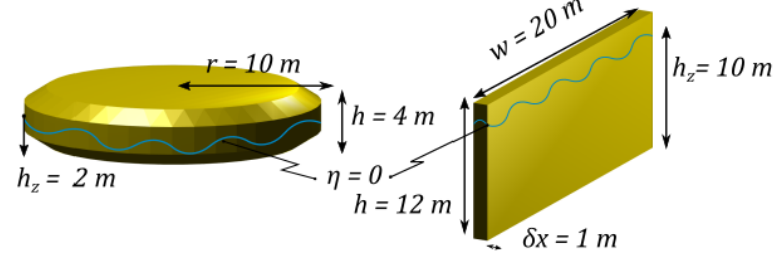
Figure 3. Heaving cylindrical WEC ( left ) and pitching OSWEC ( right ) schematic. The wavy line indicates the undisturbed free surface elevation η .